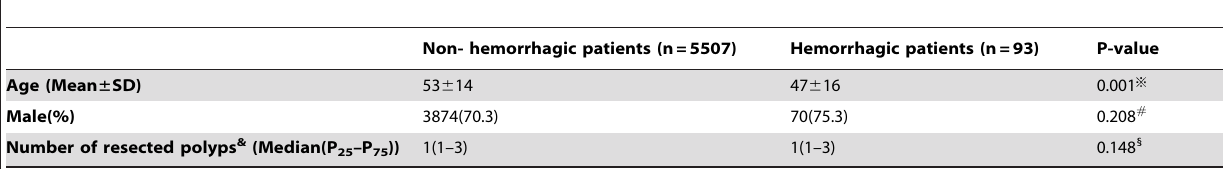
Table 4. Univariate analysis of age, gender and number of resected polyps for delayed colonic postpolypectomy hemorrhage based on